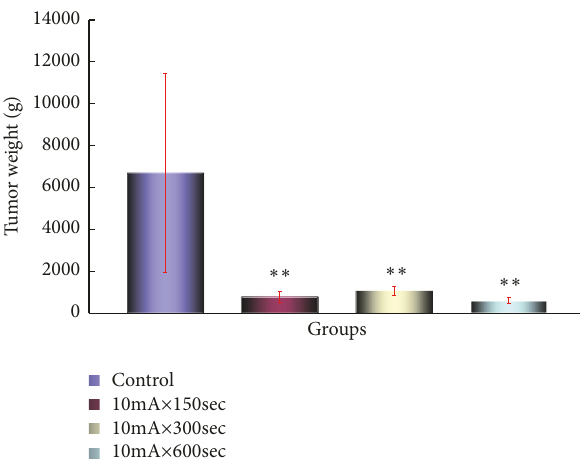
Figure 10: pH in the tumor on the cathode side. Each bar represents the mean value SE for 5 points from 8 to 10 mice. Significantly different ∗ p < 0.05 , ∗∗ p < 0.01 control vs. 10mA × 150sec, control vs. 10mA × 500sec, control vs . 10mA × 300sec, 10mA × 150sec vs. 10mA × 500sec, and 10mA × 150sec vs. 10mA ×